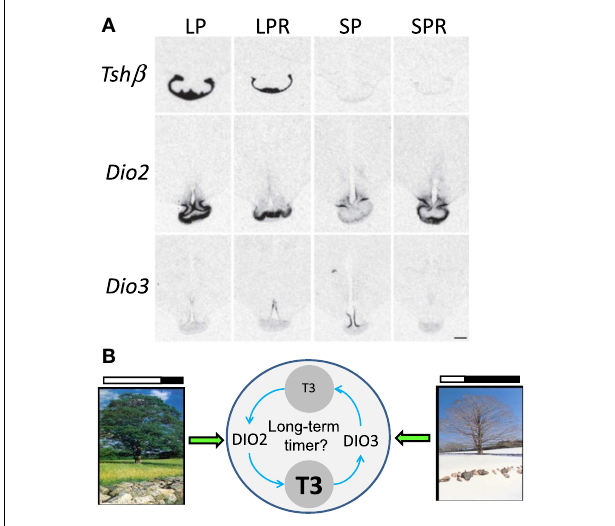
FIGURE 5 | Beyond the long-day response:TH metabolism within the MBH in long-term timing . (A) Representative images of in situ hybridization autoradiograms for Tsh β , Dio2 , and Dio3 in sheep under four different endocrine states: LP animals in a spring/summer-like state of reproductive arrest, LP refractory (LPR) animals showing spontaneous reproductive reactivation (late summer/autumn state), SP animals showing autumn/winter-like reproductive activation, and SP refractory (SPR) animals showing spontaneous reproductive arrest [adapted from Saenz de Miera et al. (157)]. (B) Schematics depicting (i) the direct effect of LP and SP on DIO2/DIO3 levels, respectively, intertwined with (ii) the possibility that their activity and the resultingTH metabolism constitutes the core of a long-term timing mechanism involved in